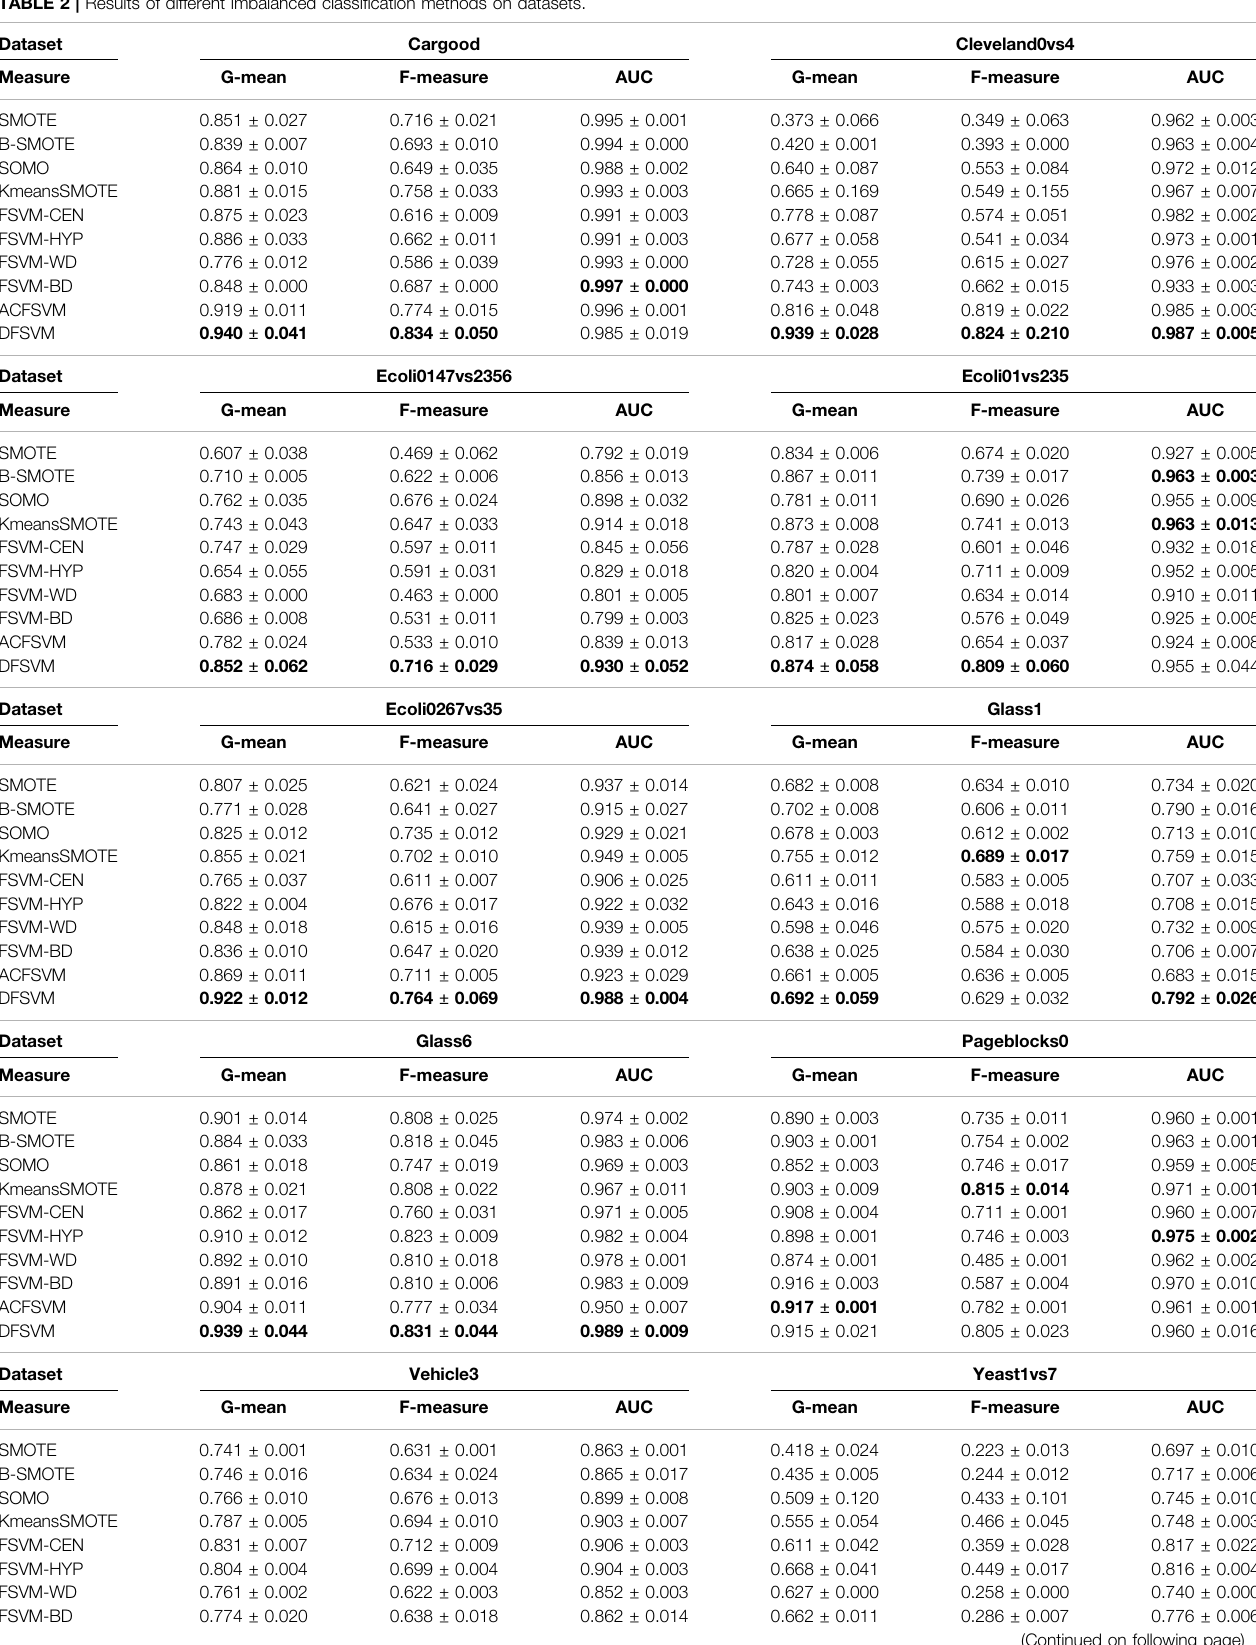
TABLE 2 | Results of different imbalanced classi fi cation methods on